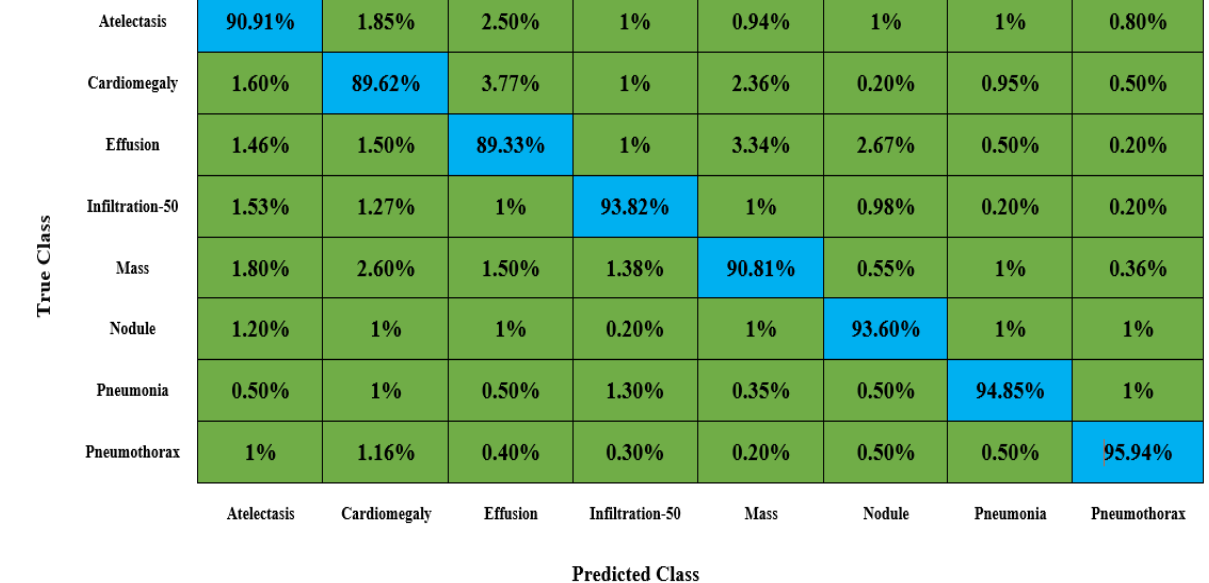
Figure 11. Attained confusion matrix results for the CXray-EffDet model .